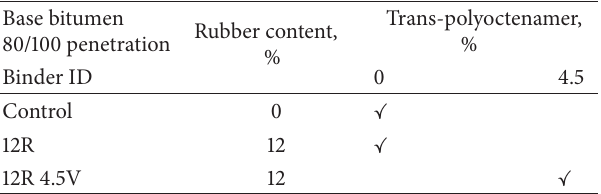
Table 5: Matrix of binders developed.